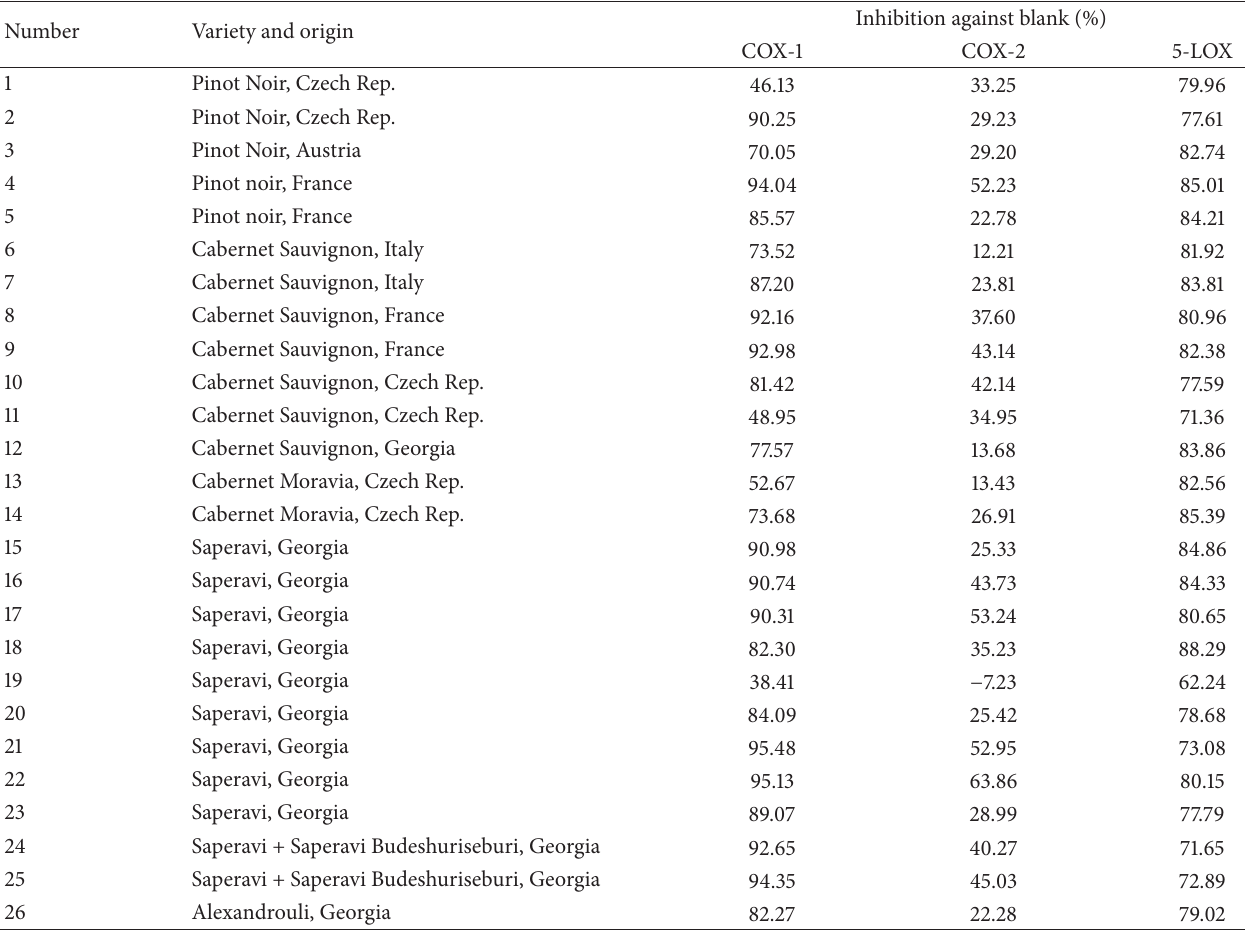
Table 1: Inhibition of COX-1, COX-2 (concentration of wine: 5mL/L), and 5-LOX (concentration of wine: 18.87 mL/L) enzymatic activity by red wines.